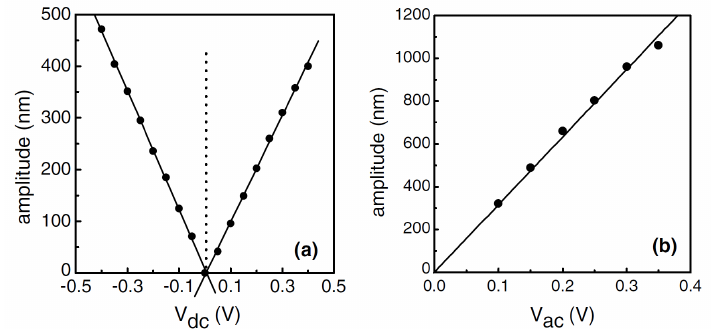
Figure 10. Measured vibration amplitude at resonance as a function of ( a ) DC voltage (V ac = 0.3 V) and ( b ) AC voltage (V dc = 0.2 V) for 200 µ m SiC cantilever [45]. Reprinted from Microelecton. Eng., 78–79, Jiang et al., Dry release fabrication and testing of SiC electrostatic cantilever actuators, 78–79, c (cid:13) 2005, with permission from